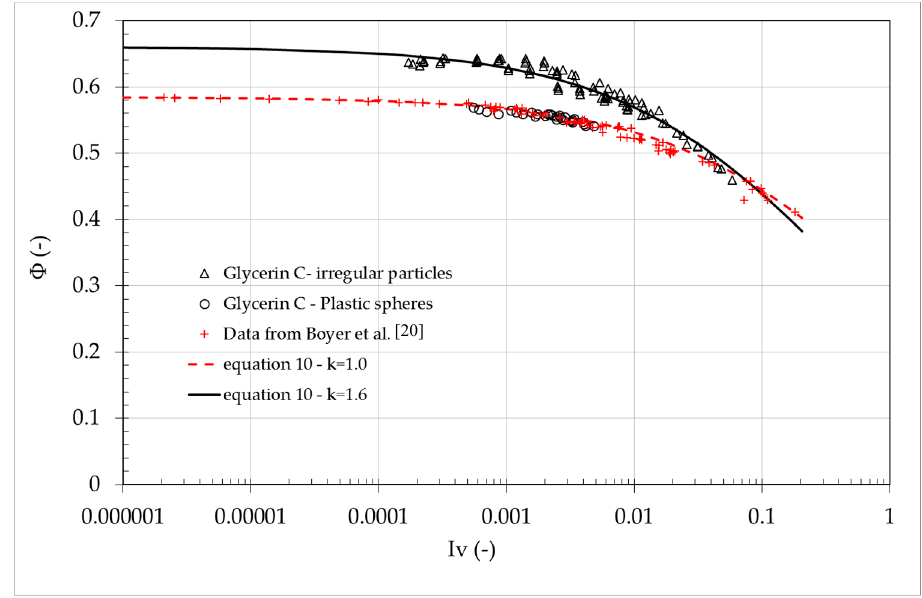
Figure 13. Plastic irregular particle–glycerin C solution. Correlation between the volume fraction Φ and the viscous number I v compared with the experimental results for the plastic sphere–glycerin C solution and the data reported by Boyer et al. [20] for viscous suspensions with spheres. Solid lines depict the power law behavior Equation 10 for irregular particles ( k = 1.6) and dashed line for spheres ( k = 1).